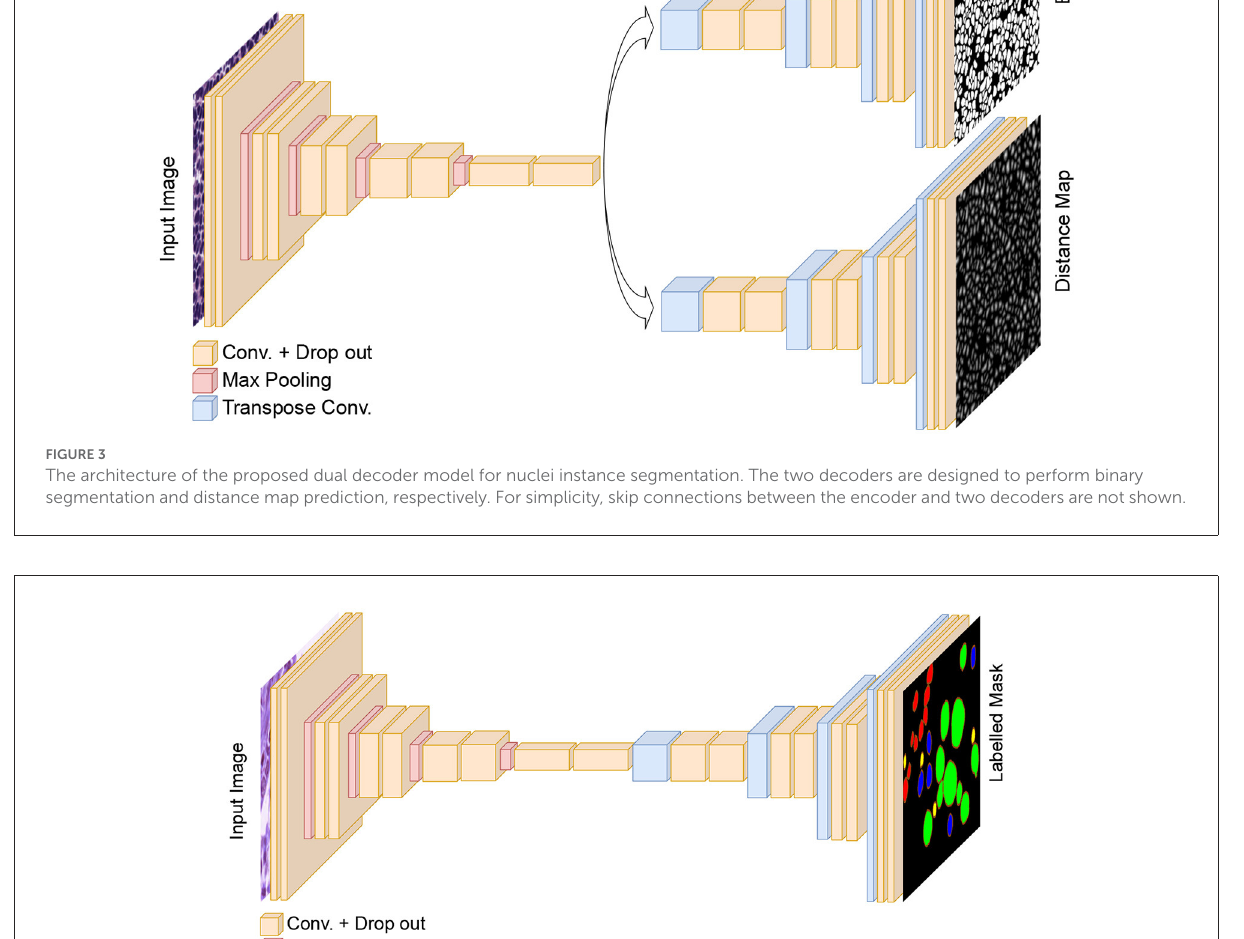
of the classification model to choose the nucleus type for each